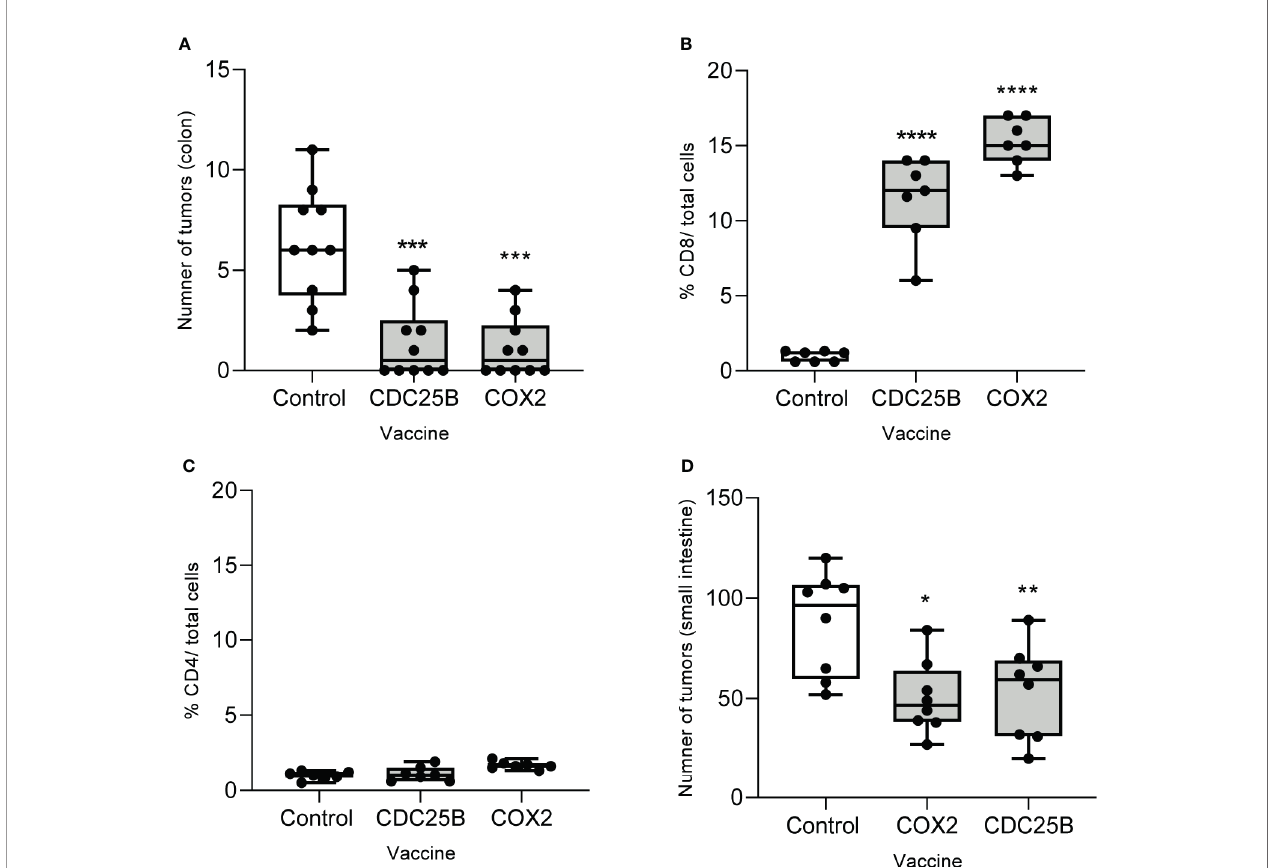
FIGURE 5 | Multi-peptide vaccination with epitopes derived from CDC25B or COX2 prevents the development of tumors in both the colon and small intestine. (A) The number of tumors in the colon from AOM-treated mice immunized with the indicated vaccine; n = 10/group. Percent of (B) CD8 + or (C) CD4 + T cells out of total cells quanti fi ed by immunohistochemistry on tumors collected from AOM-treated mice after immunization with the indicated vaccine. n = 7/group. (D) Number of tumors in the small bowel after APC-min mice were immunized with the indicated vaccine; n = 8/group. All data are presented as box and whisker plots, horizontal line at median and whiskers min to max; *p < 0.05, **p < 0.01, ***p < 0.001, ****p <